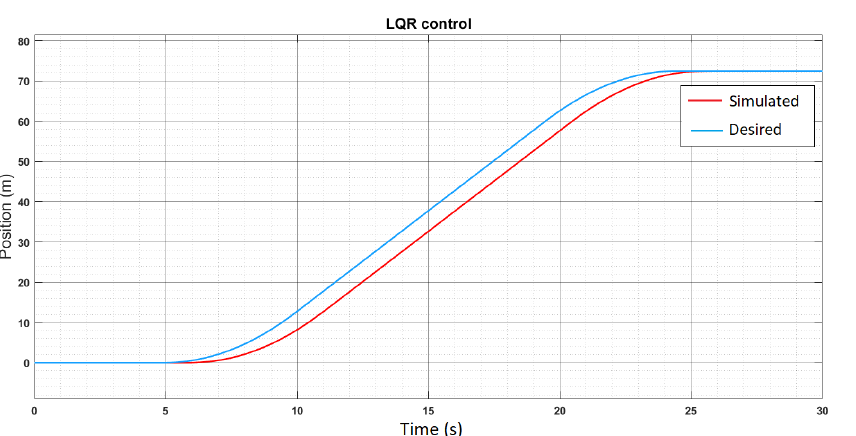
Figure 14. Reference point.